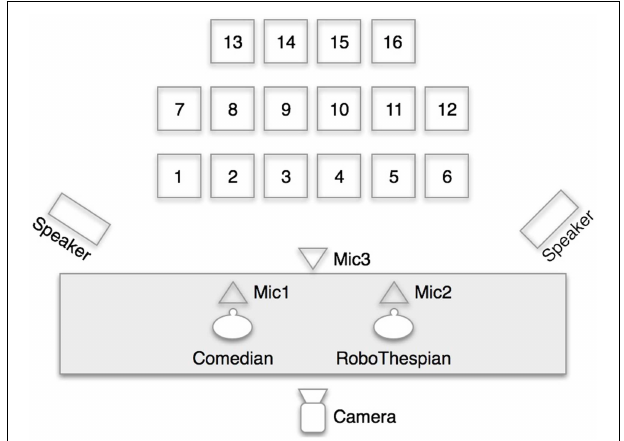
FIGURE 3 | Barbican Comedy Lab